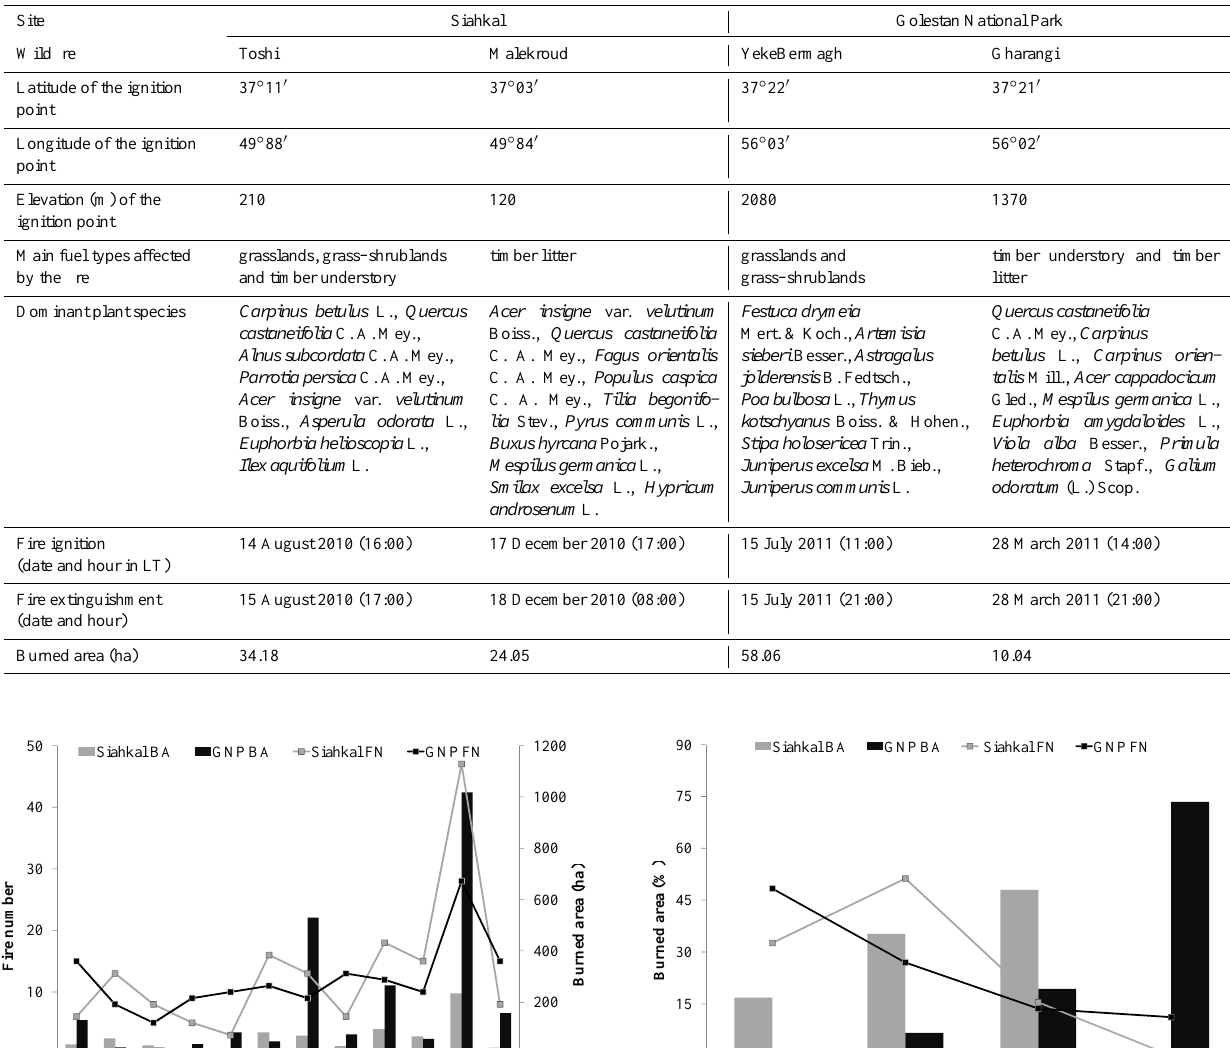
Table 1. Case study description.